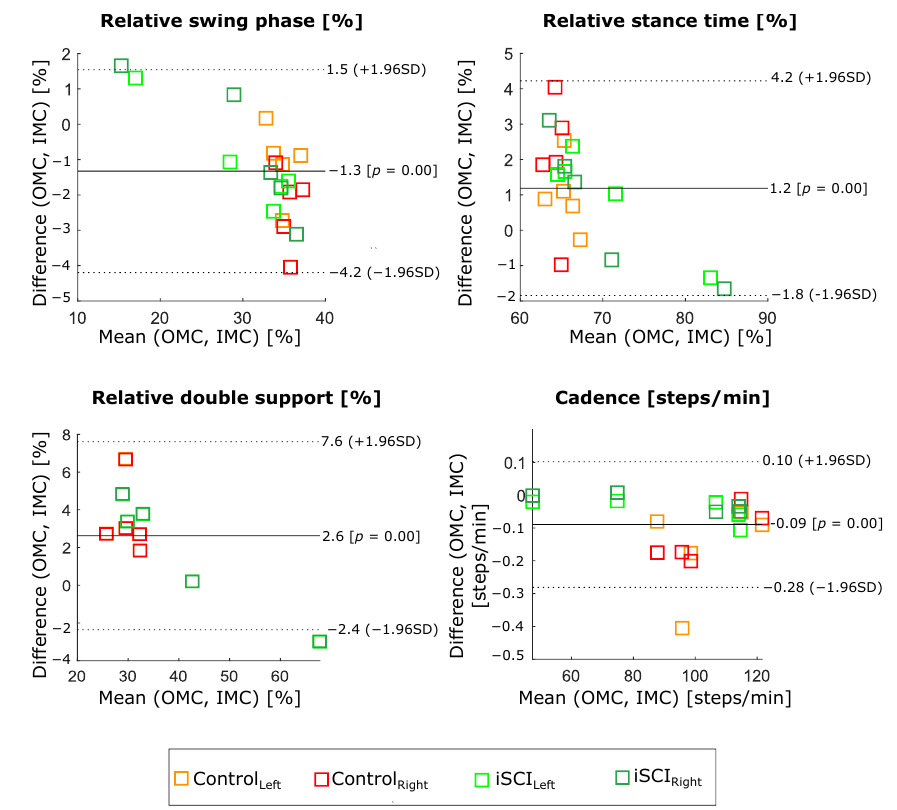
Figure 4. Bland–Altman graphs represent the difference scores of calculated relative swing, stance, double-support phases, and cadence from two IMUs placed on the shoes versus OMC system while the participants (5 controls and 5 iSCIs (823 strides)) were walking on the